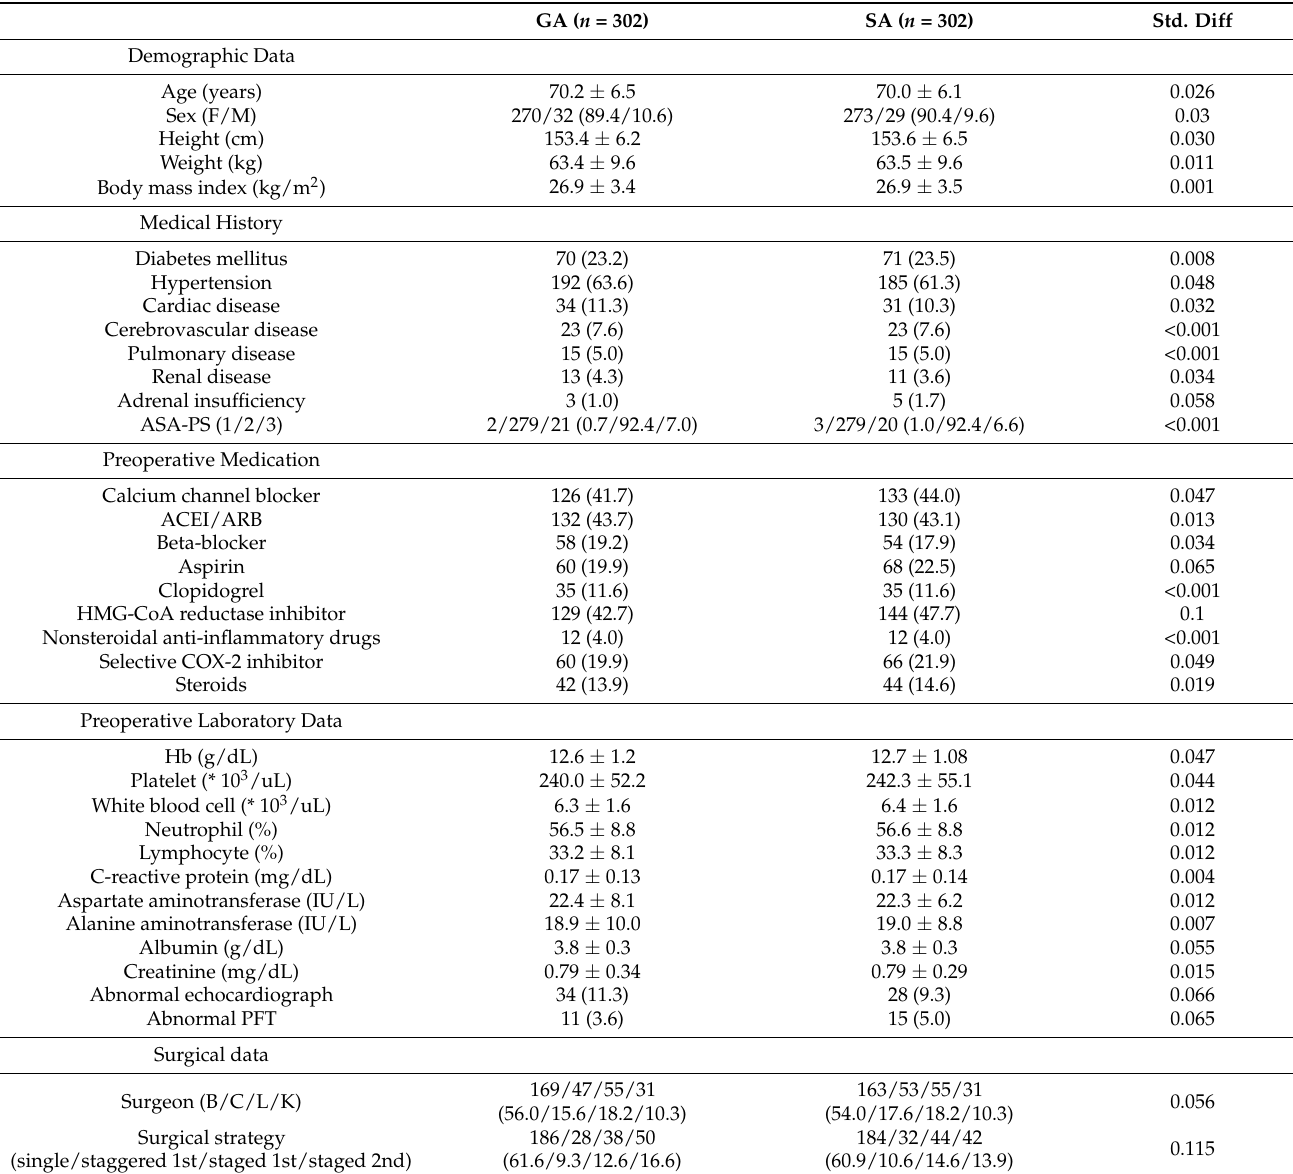
Table 2. Demographic and preoperative data in propensity score-matched